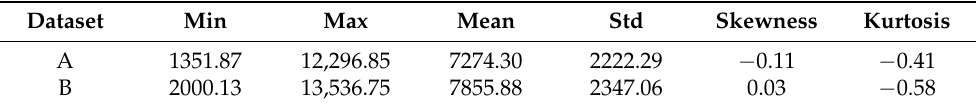
Figure 3. Division of electricity load datasets. Table 1. Statistical information of the datasets.